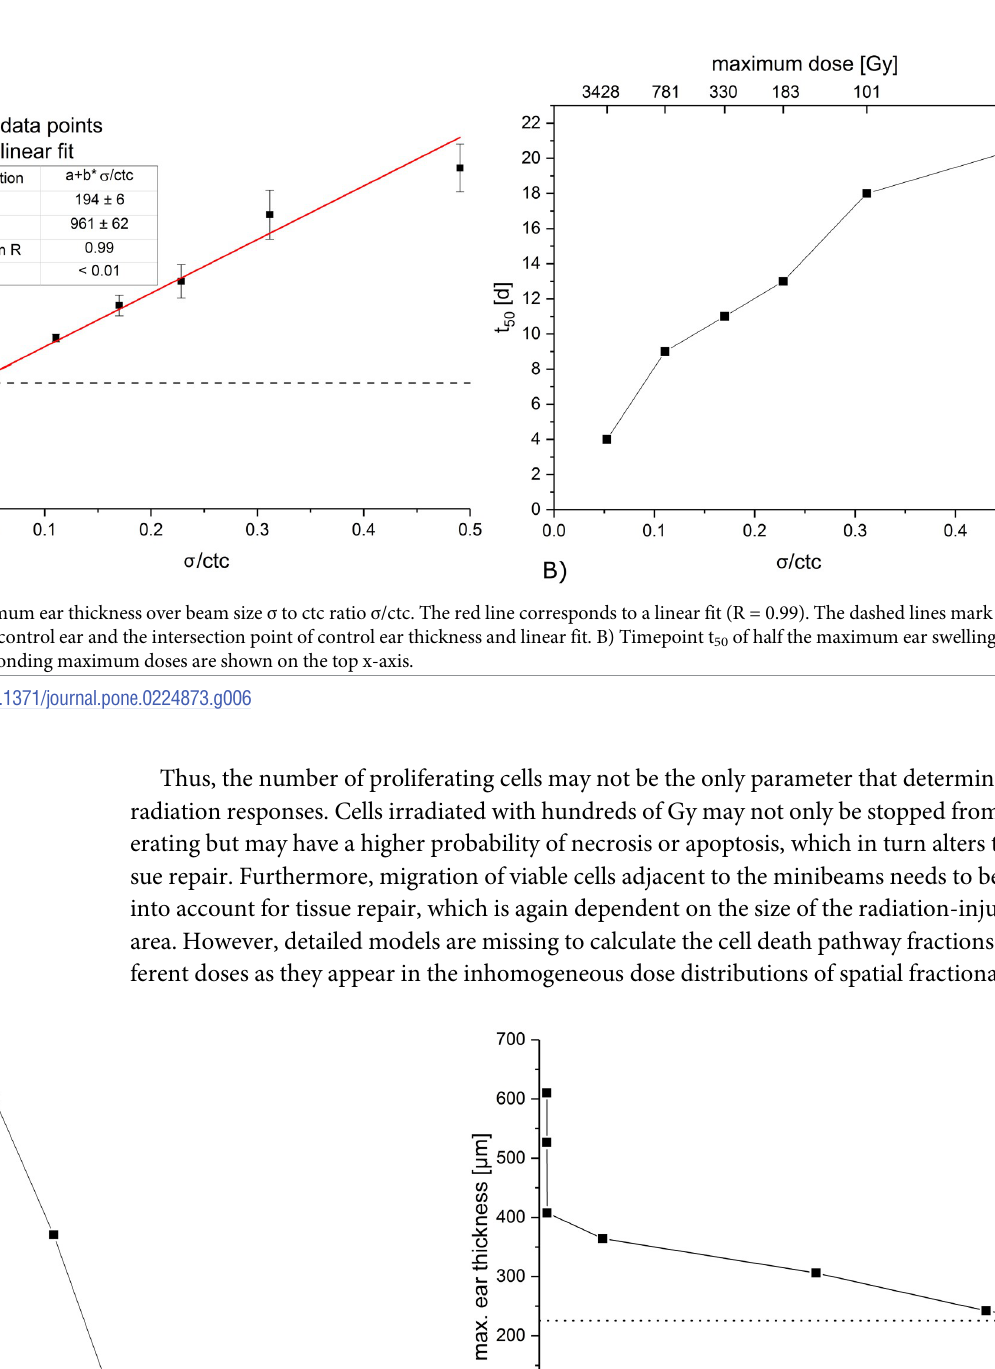
Fig 7. A) Clonogenic cell survival of mouse keratinocytes in dependence of the σ /ctc ratios. B) Maximum ear thickness over the calculated clonogenic cell survival of the corresponding σ /ctc. The dotted line marks the max. ear thickness of the unirradiated